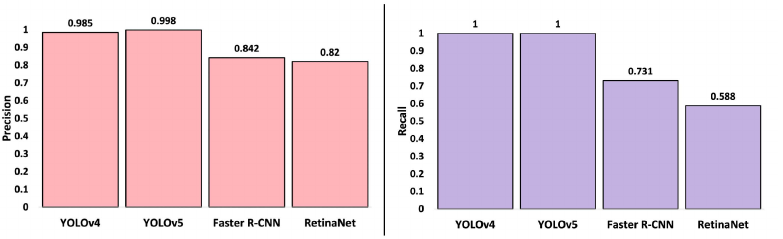
Figure 7. Performance metrics for a variety of object detection networks. Two YOLO architectures as well as the Faster R-CNN and RetinaNet methods are compared in terms of precision and